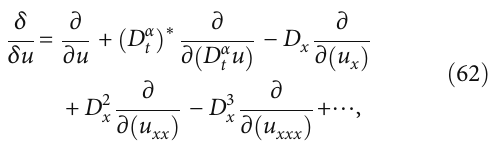
Figure 2: The solution u